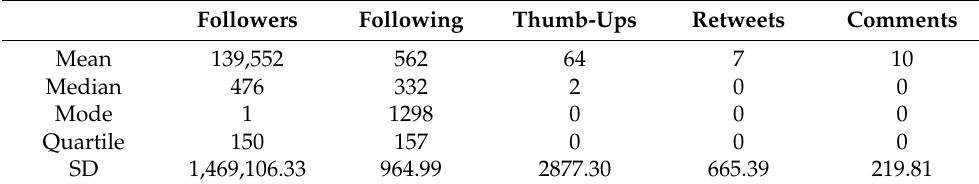
Table 1. Descriptive statistics of Microblog users and diary